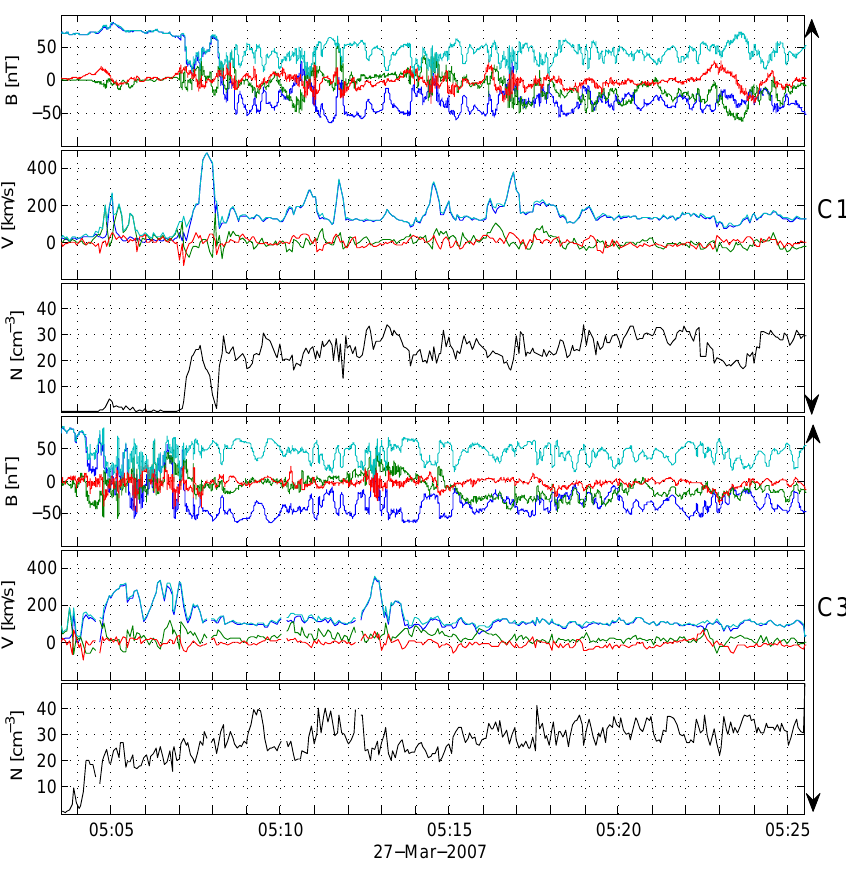
Fig. 3. Magnetic field, ion velocity and ion density recorded by Cluster 1 and 3 during event 1, on 27 March 2007 at 05:04–05:25UT at the magnetopause approximately 4 R E north from the subsolar point. For B and V , light blue curve gives the absolute magnitude. Dark blue, green and red are L , M and N components, respectively, in boundary normal coordinates defined in the